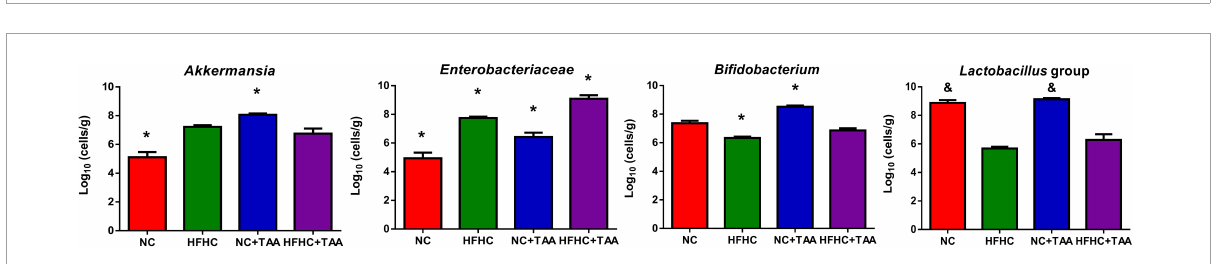
FIGURE8 Bacterial concentration. Bars charts (mean ± SEM) represent the concentration of Akkermansia genus, Enterobacteriaceae family, Bifidobacterium genus, and Lactobacillus group analyzed by qPCR (log 10 cells/g feces). Comparisons through Kruskal–Wallis ( Akkermansia, p < 0.000; Lactobacillus , p < 0.000) followed by Dunn’s test and the one-way ANOVA ( Enterobacteriaceae, p < 0.000; Bifidobacterium , p < 0.000) followed Tukey’s test, showed differences among groups studied (* p < 0.05, comparison with all the groups; & p < 0.05,